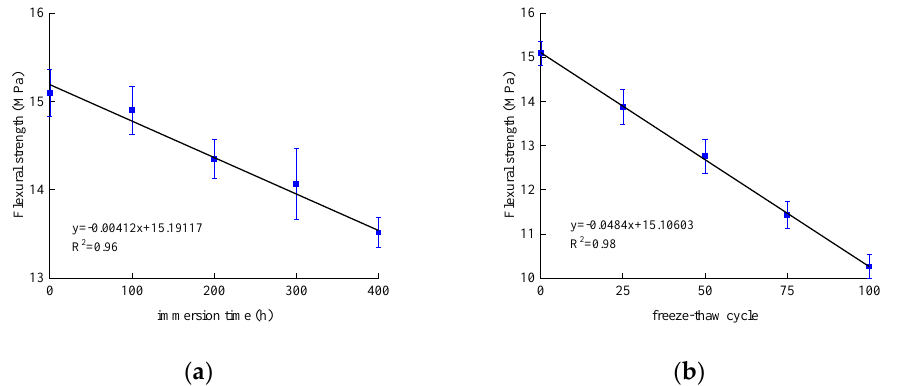
Figure 27. Flexural strength of unreinforced concrete specimen: ( a ) chlorine salt immersion environ- ment and ( b ) salt-freeze coupled environment. Table 9. Deflection of concrete flexural specimen. Table 9. Deflection of concrete flexural specimen.